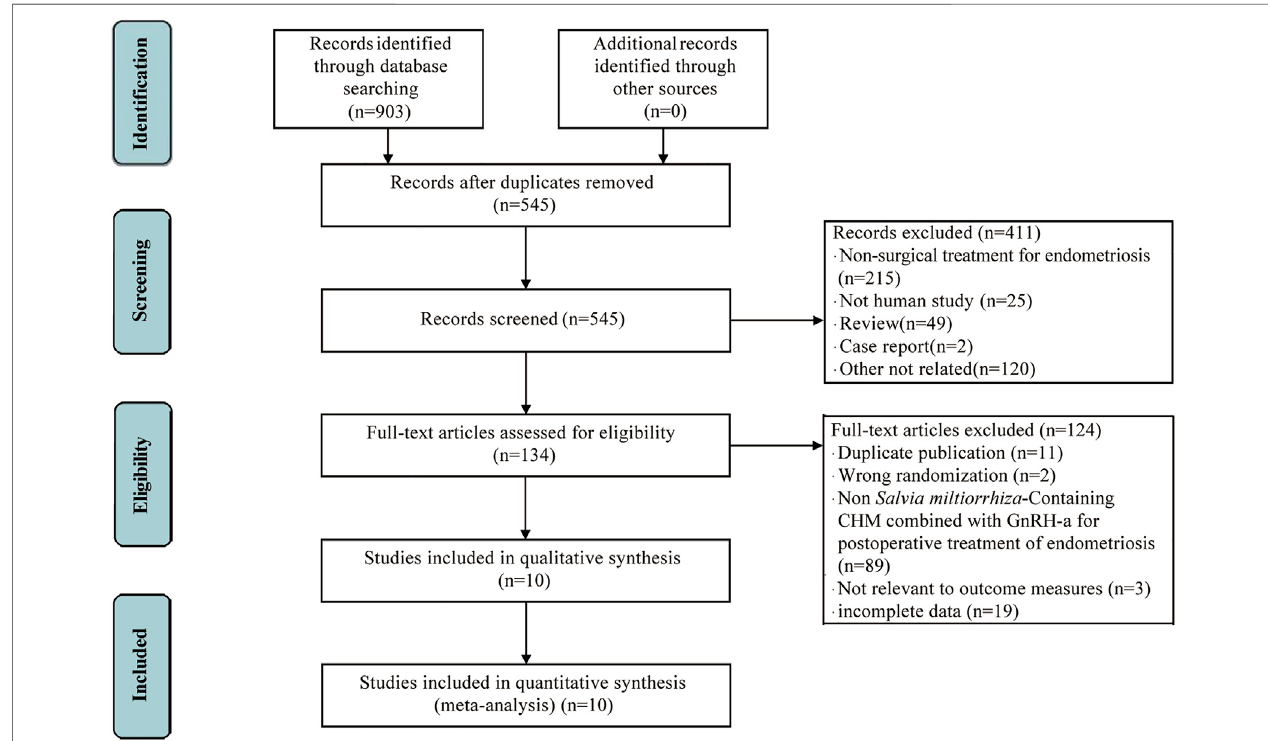
FIGURE 1 | Flow chart of studies selection